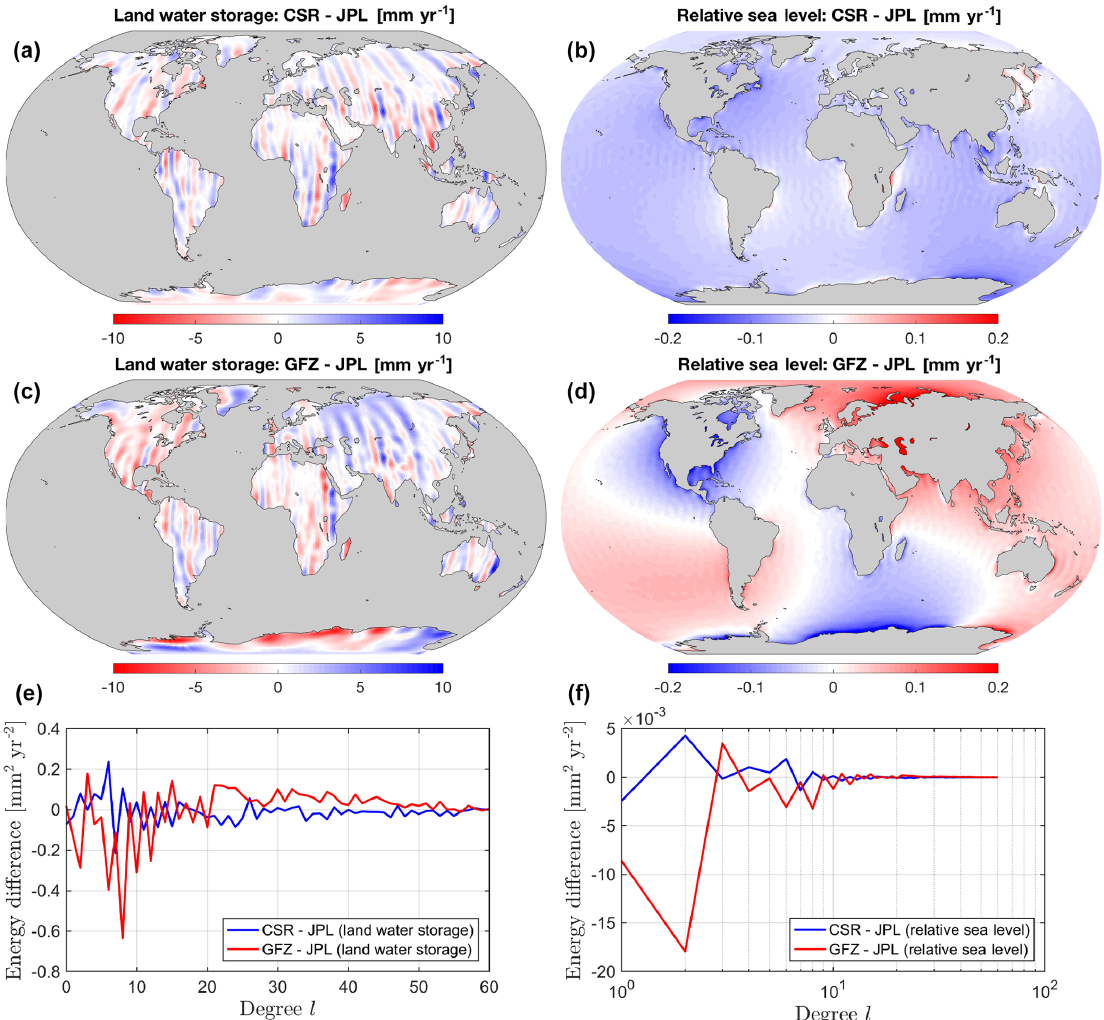
Figure 4. Comparison of data centers for select fields. JPL solutions are subtracted from CSR and GFZ solutions for trend in land water storage change (a, c) and relative sea-level change (b, d) during January 2003–December 2013. The difference in the spectrum of energy distribution is also shown (e, f) . Results are computed in the CM reference frame with the rotational feedback accounted for.